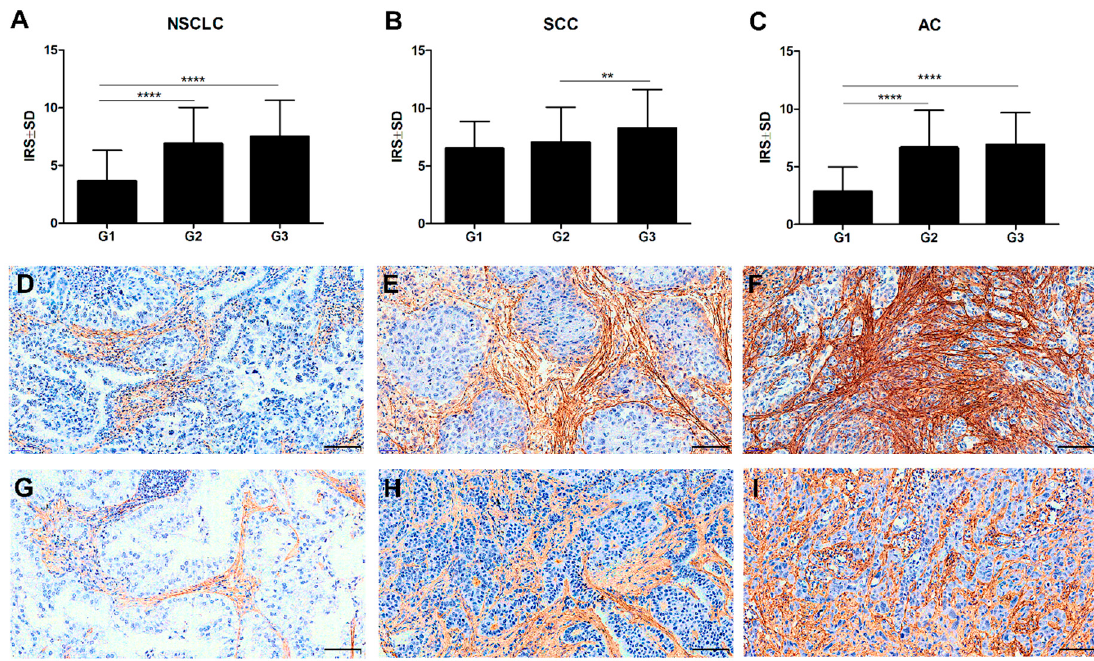
Figure 6. Comparison of periostin (POSTN) expression levels in different grades of malignancy ( G ) of the tumour in ( A ) non-small cell lung carcinoma (NSCLC) (**** p < 0.0001), ( B ) squamous cell cancer (SCC) (** p < 0.005), and ( C ) adenocarcinoma (AC) (**** p < 0.0001); Mann–Whitney U test. Immunohistochemical expression of periostin (POSTN) in stromal cells increased with a higher malignancy grade ( G ) in squamous cell cancer (SCC): G1 ( D ), G2 ( E ), G3 ( F ), and in adenocarcinoma (AC): G1 ( G ), G2 ( H ), and G3 ( I ). Magnification 200×. Bar = 100 µm.